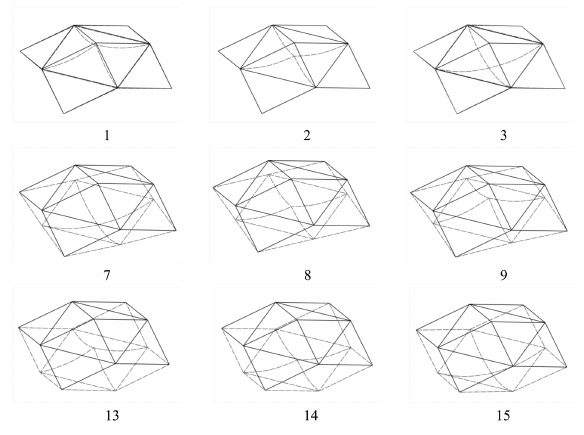
Figure 13: Sixteen-member structure displacements (Case 2 - λ up = 36.7 )